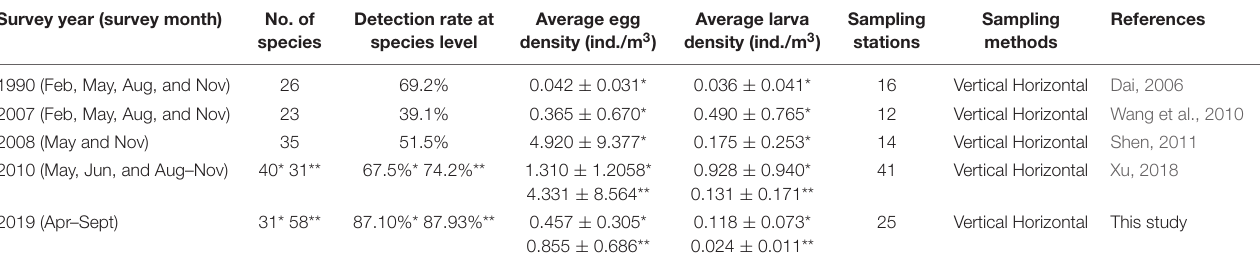
TABLE 5 | The interannual variations of the number of species and the average density (ind./m 3 ) (mean ± SD, n = 4 in 1990 and 2007, n = 2 in 2008, and n = 6 in 2010 and 2019) of fish eggs and larvae throughout the years in Sansha Bay of Fujian Province, China. Survey year (survey month)